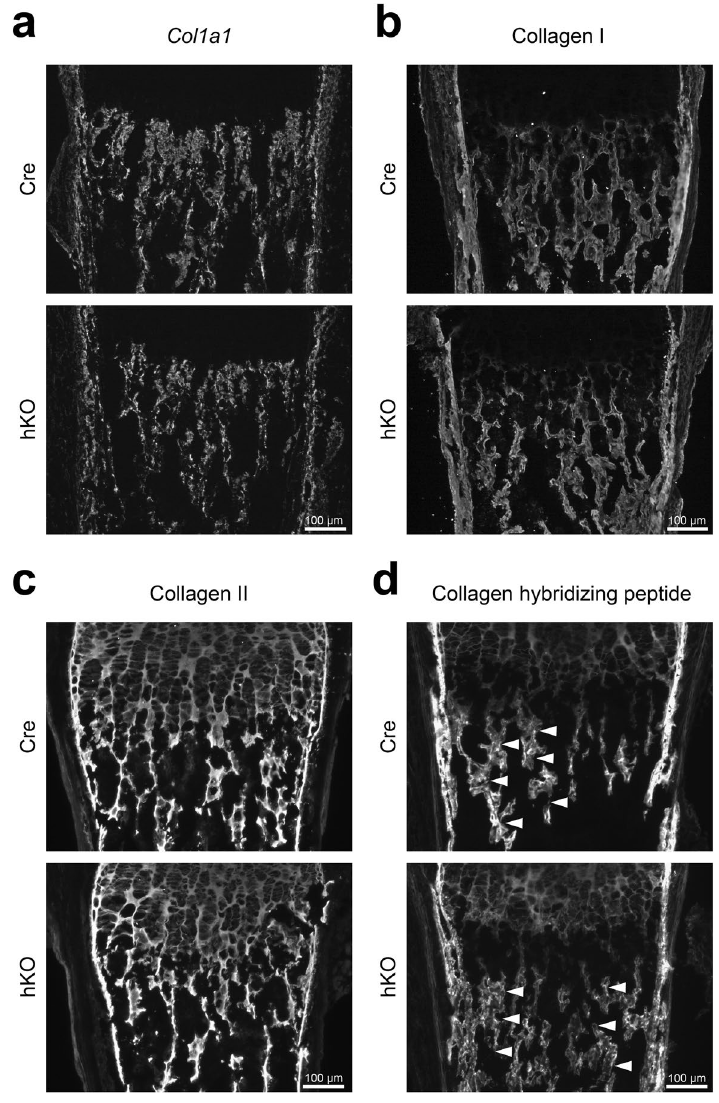
Figure 2. Analysis of the abundance of fibrillar collagens in femoral sections of Mirc24 cluster-deficient mice. Detection was performed on plane matched sections of femora from newborn male Col2a1-Cre (Cre) and Col2a1-Cre- Mirc24 tm1M/Y (hKO) mice. ( a ) Col1a1 mRNA distribution was analyzed by fluorescence in situ hybridization using a Col1a1 specific fluorescence probe. The abundance of ( b ) collagen I and ( c ) collagen II was studied by immunofluorescence. ( d ) In addition, to study bone remodeling the binding of collagen hybridizing peptide to unfolded collagen chains was analyzed by fluorescence microscopy. Note reduced intensity of the trabecular staining (arrowheads). Brightness was adjusted for visualization ( a – c ) using Adobe Photoshop Elements 2020 (Version 18.0, https:// www. adobe. com/ produ cts/ photo shop- eleme nts. html). Four animals per genotype were analyzed and representative images are shown. Additional images are shown in Supplementary Figs. S1 and S2 online. The figure was created using Adobe Illustrator CS6 (Version 16.0.3, https:// adobe. com/ produ cts/ illus